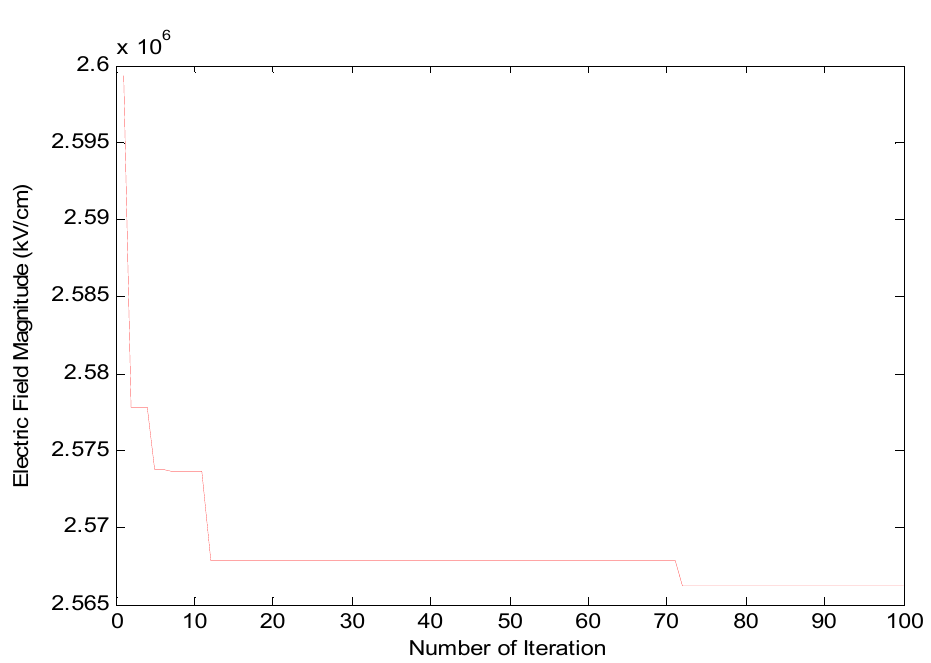
Figure 13. Simulation results for GWO after 100 iterations.